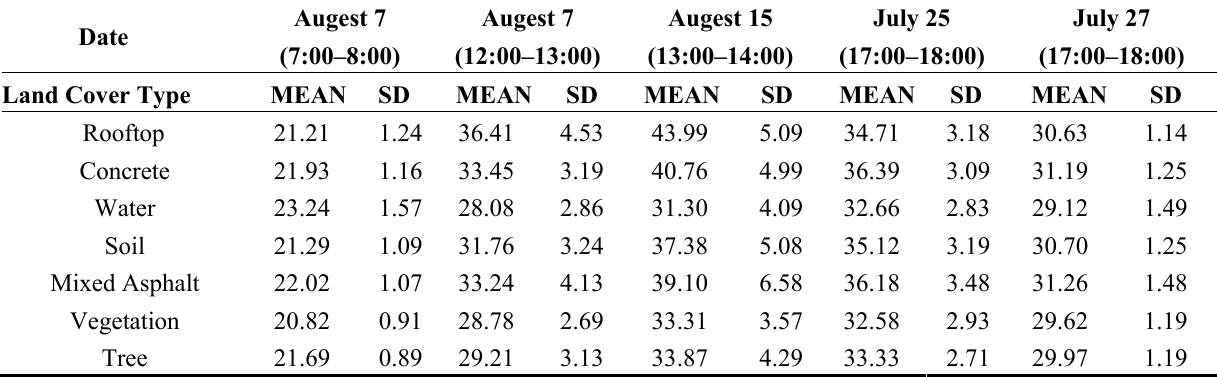
Figure 10. LST derived from TASI imagery on ( a ) the morning of 7 August 2010; ( b ) the noon of 7 August 2010; ( c ) the noon of 15 August 2010; ( d ) the evening of 25 July 2010; and ( e ) the evening of 27 July 2010. (Note that the white regions are those could not pass the data quality control.) Table 8. Descriptive statistics of LST (in °C) derived from TASI LST images over different land cover types in 2010 (the overpass time is in local